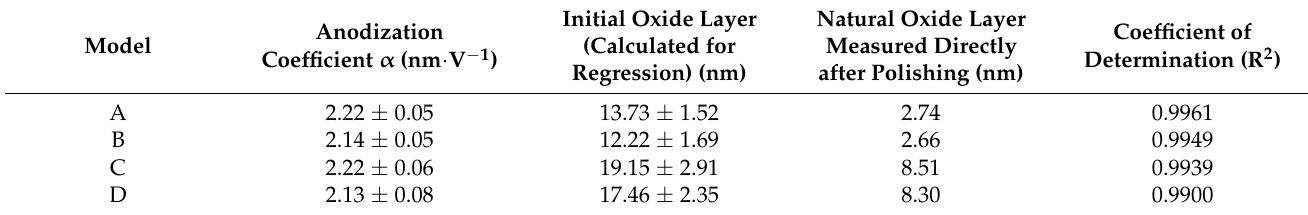
Table 2. Anodization coefficients and oxide thickness obtained from linear